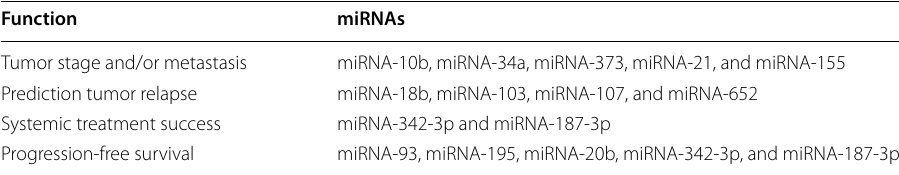
Table 1 miRNAs and their function in breast cancer [57–60] Function Tumor stage and/or